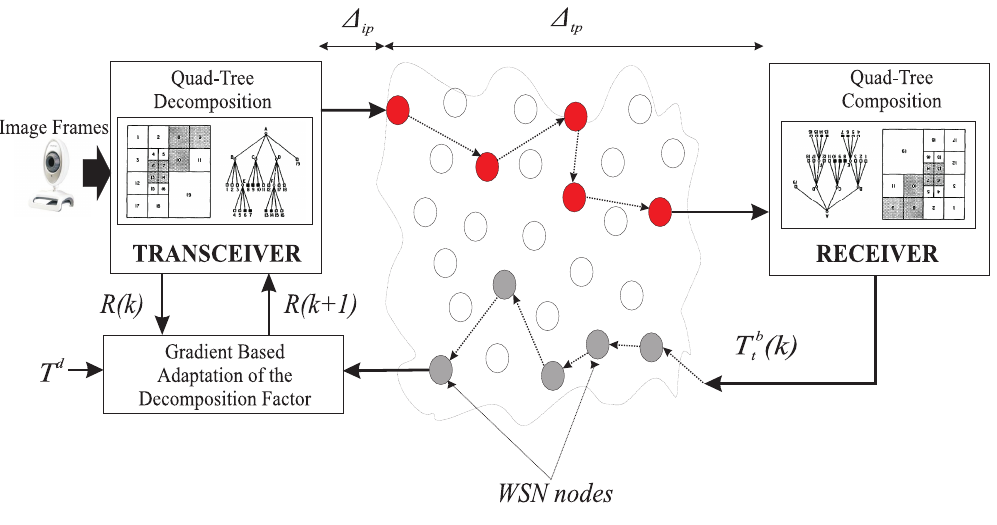
Figure 6 . Architecture of the Image Transmission Scheme over a